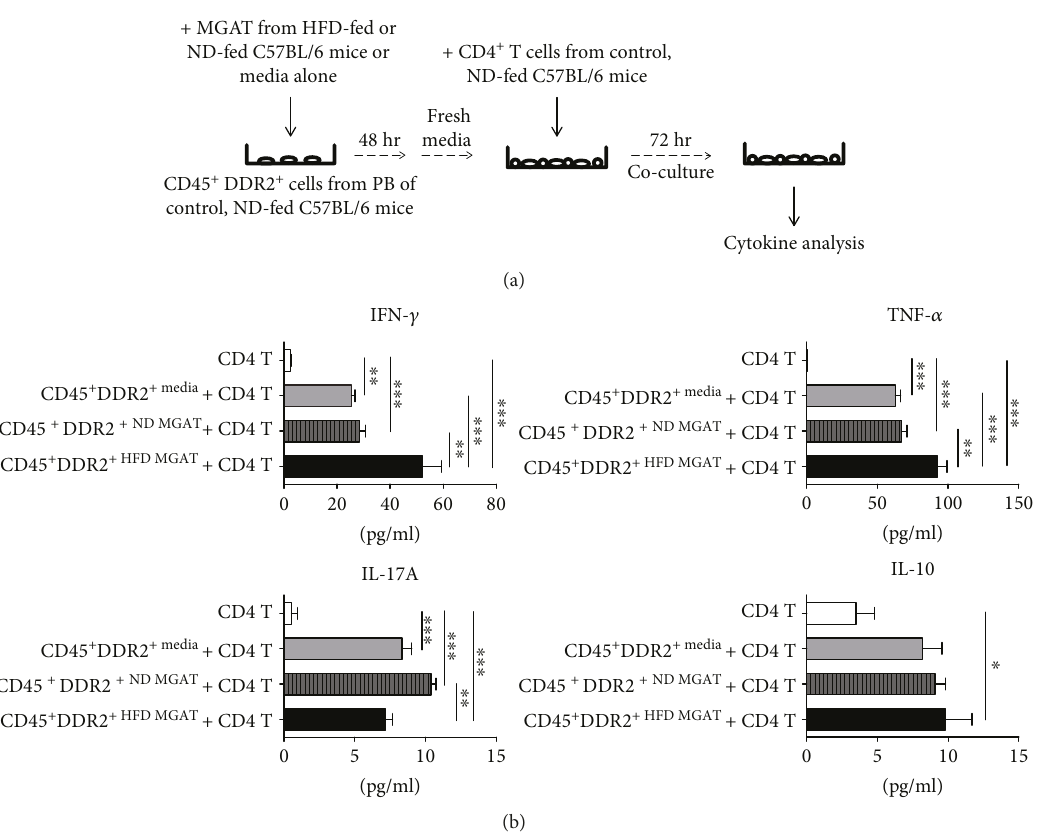
Figure 4: MGAT from HFD-fed mice triggers CD45 + DDR2 + cells to elicit increased production of IFN- γ and TNF- α from CD4 + T cells. (a) Experimental overview: sorted CD45 + DDR2 + cells from peripheral blood of control, ND-fed C57BL/6 mice were cultured in media conditioned by MGAT from HFD- or ND-fed mice at 1 × 10 4 cells/well for 48h at 37 ° C. For T cell coculture, media was replaced and splenic CD4 + T cells from control, ND-fed C57BL/6 mice were added to CD45 + DDR2 + cell cultures at 1 × 10 5 cells/well for 72h. Supernatants were collected and levels of Th1-, Th2-, and Th17-associated cytokines were analyzed by cytometric bead array. (b) Graphical representation of levels of IFN- γ , TNF- α , IL-17A, and IL-10 detected in supernatants. Data are presented as mean ± SEM of triplicate wells analyzed in duplicate. ∗ p < 0 05 , ∗∗ p < 0 01 , and ∗∗∗ p < 0 001